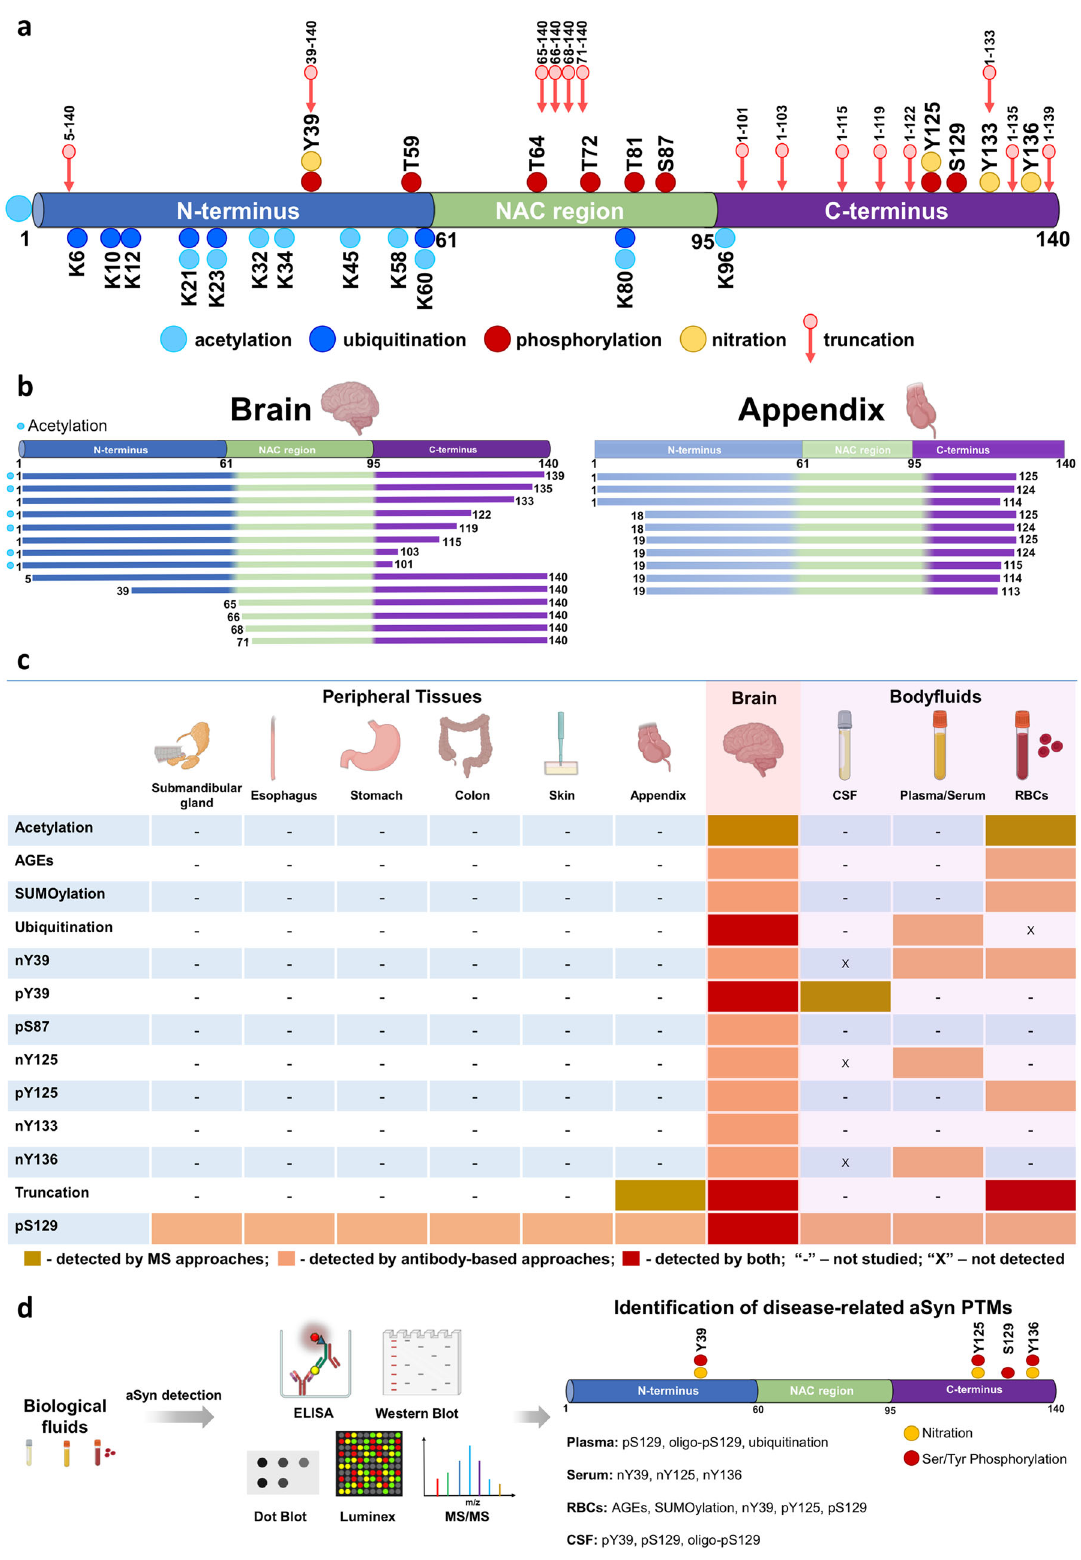
other synucleinopathies; (3) present a gap analysis to help guide future aSyn biomarker studies; (4) highlight some of the current challenges in targeting modi fi ed and aggregated aSyn species as potential biomarkers for PD; and (5) provide an overview of